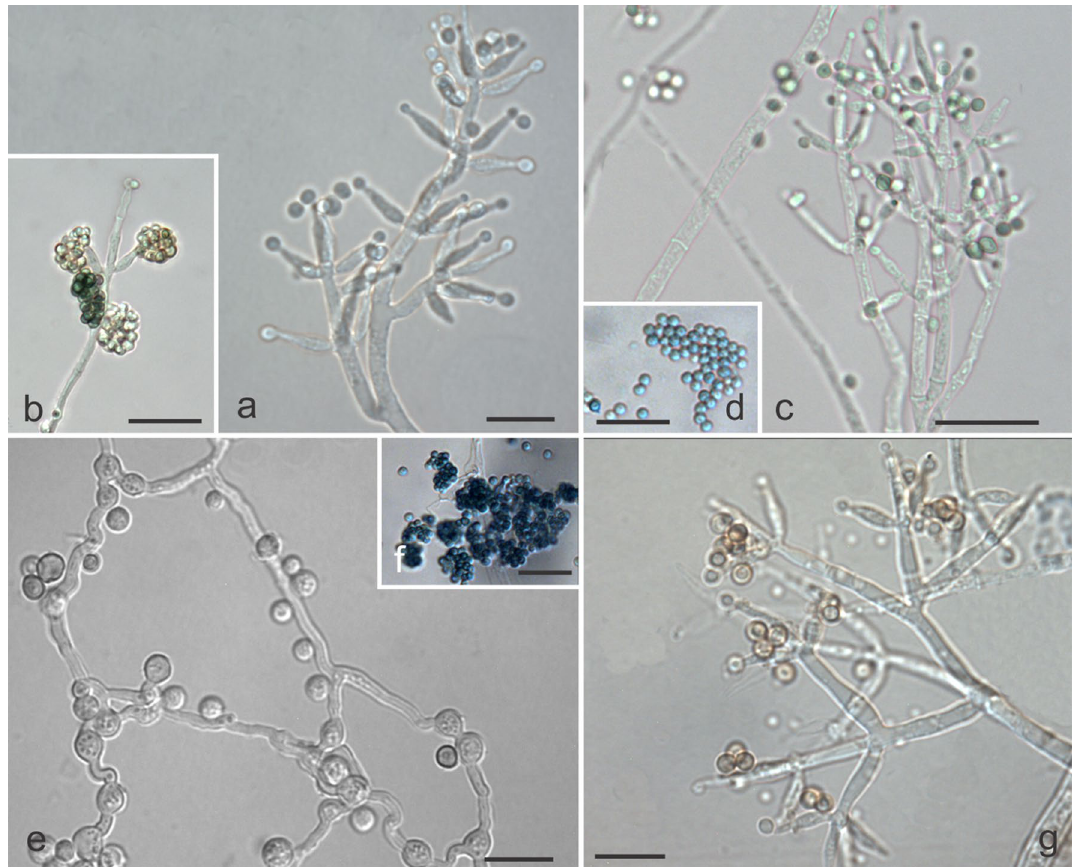
Figure 10. Morphological features characteristic of Trichoderma caeruloviride sp. nov. (COAD 2416). ( a , b , c , g ) Conidiophores and phialides formed on SNA and CMD. e chlamydospores on CMD. ( f , d ) Blue conidia.